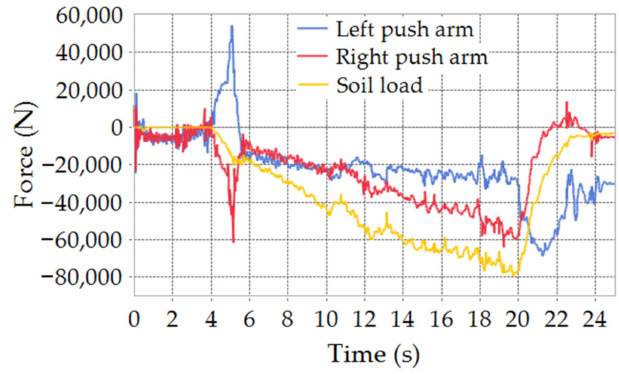
Figure 6. Soil load and joint